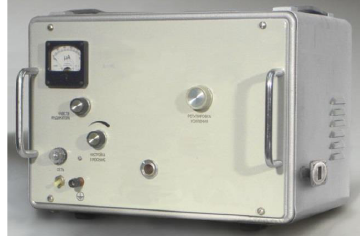
Fig. 4 . General view of the device for measuring the chemiluminescence of